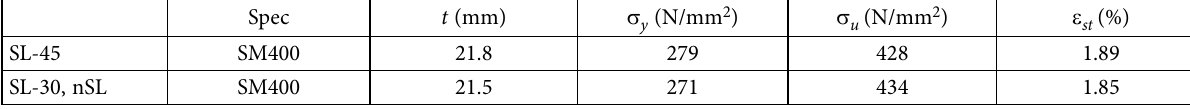
Table 3. Material properties of the steel plates for knee